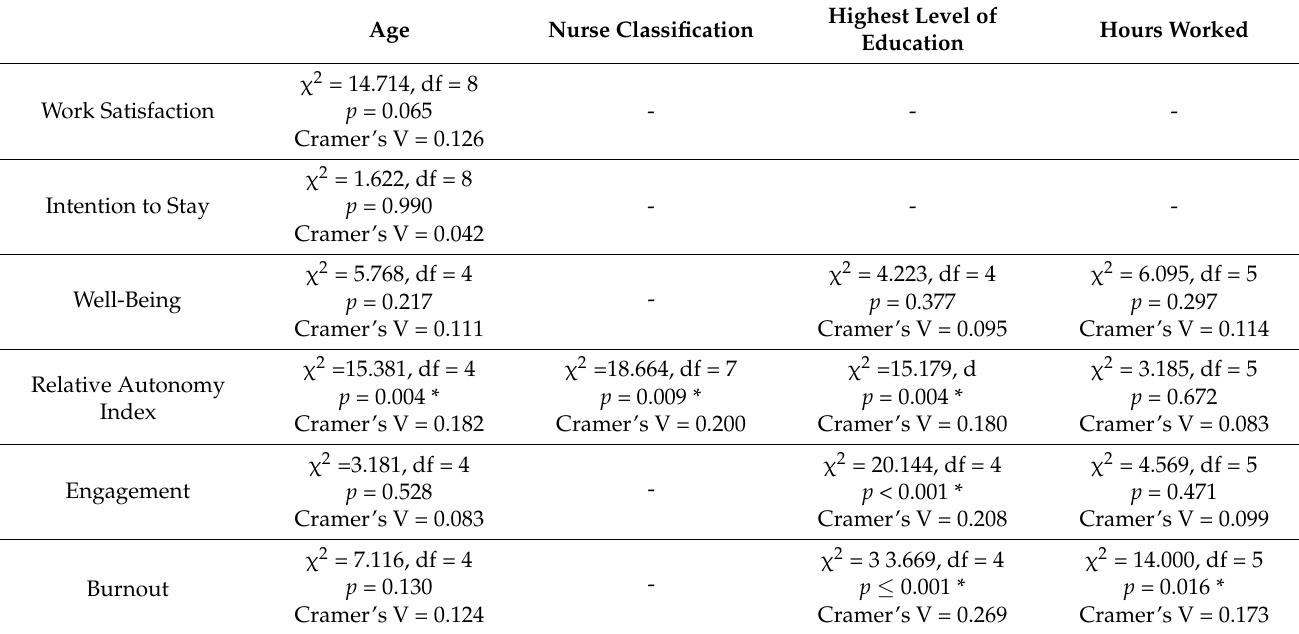
Table 3. Group variables–Pearson Chi-Square Test for Independence (N = 466).